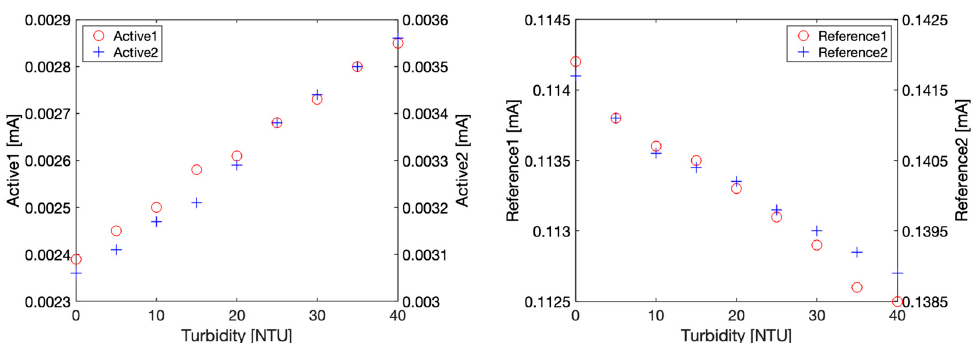
Figure 7. Photodetector current characterization obtained with benchtop instruments with Formazin solutions ranging from 0 to 40 NTU. Left : 90° nephelometric configuration current for Active1 and Active2 signals. Right : 180° attenuation configuration current for Reference1 and Reference2 signals.